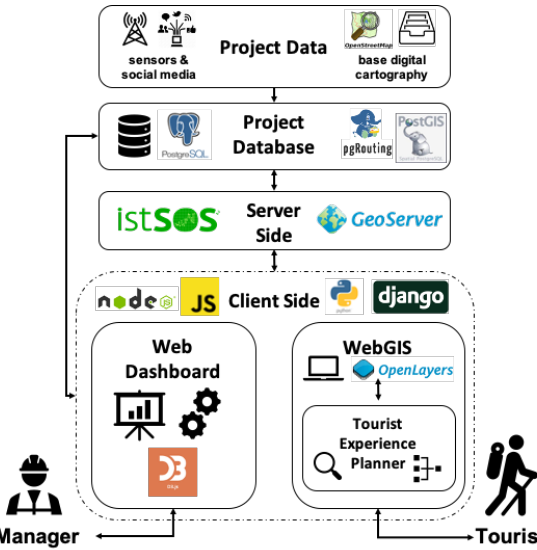
Figure 2. Schematic software architecture of the INSUBRI.PARKS IT